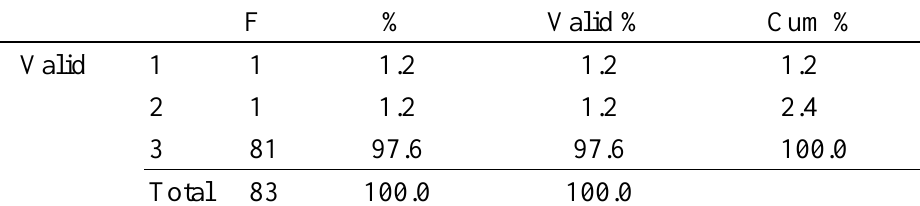
Tabel 4 . P1 Pengaksesan Media Televisi